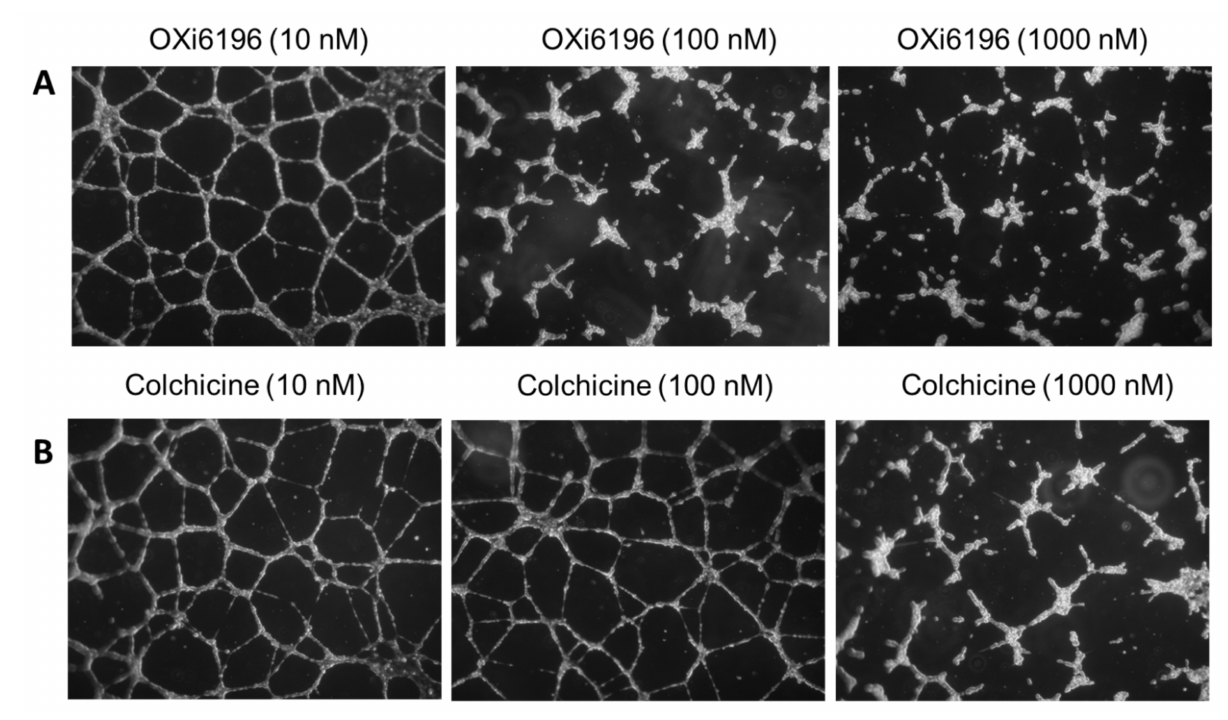
Figure 4. Capillary network disruption. ( A ) HUVEC capillary-like networks cultured on Matrigel ® showed dose-dependent tube disruption with OXi6196 treatment becoming significant at 100 nM. ( B ) Colchicine ultimately showed similar activity, but at about 10 × higher concentration. Cells were imaged with an inverted microscope (5 × ) and nine fields were photographed per well. A minimum of three independent experiments was carried out for each treatment, and representative images are shown. An example of untreated control is shown in Figure S4.